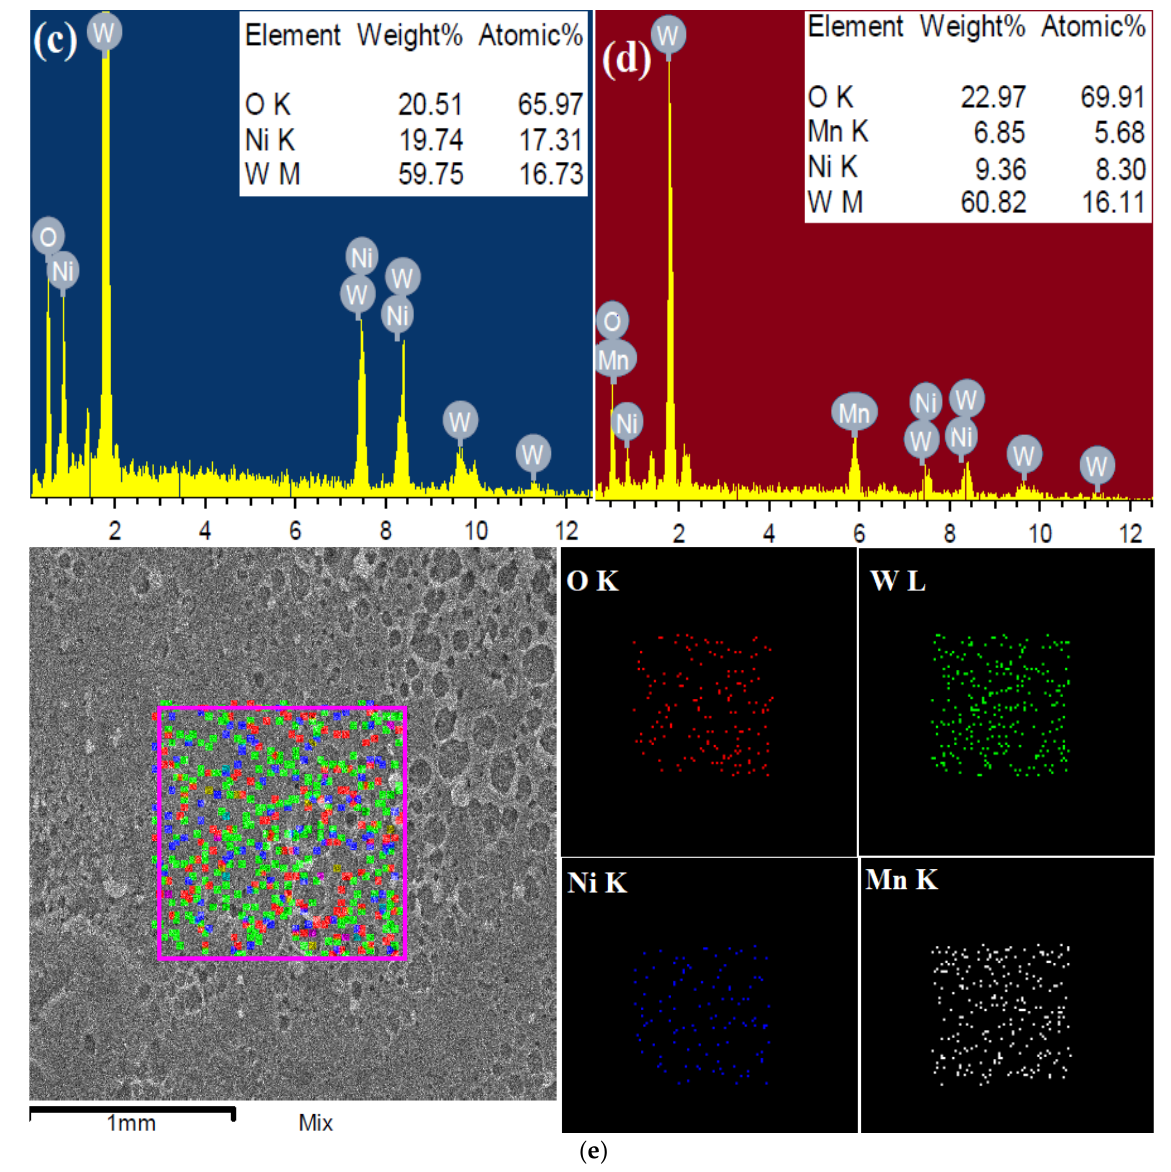
Figure 4. SEM-EDX image of ( a , c ) NiWO 4 ( b , d ) Ni 1 – x Mn x WO 4 NC. ( e ) Selected area mapping of elements composing the synthesized nanocomposite.